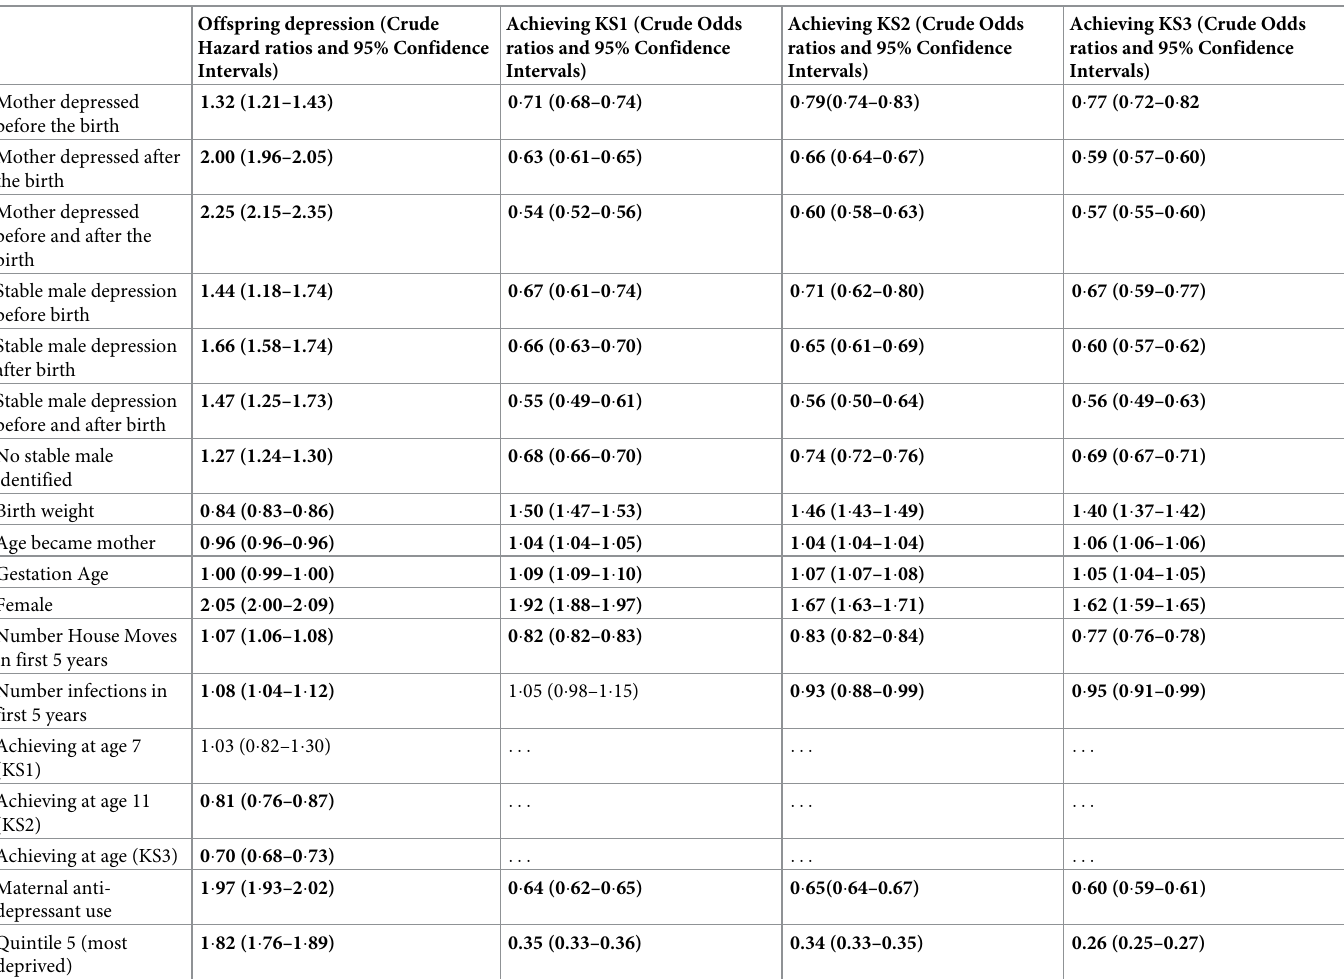
Achieving KS1 (Crude Odds ratios and 95%